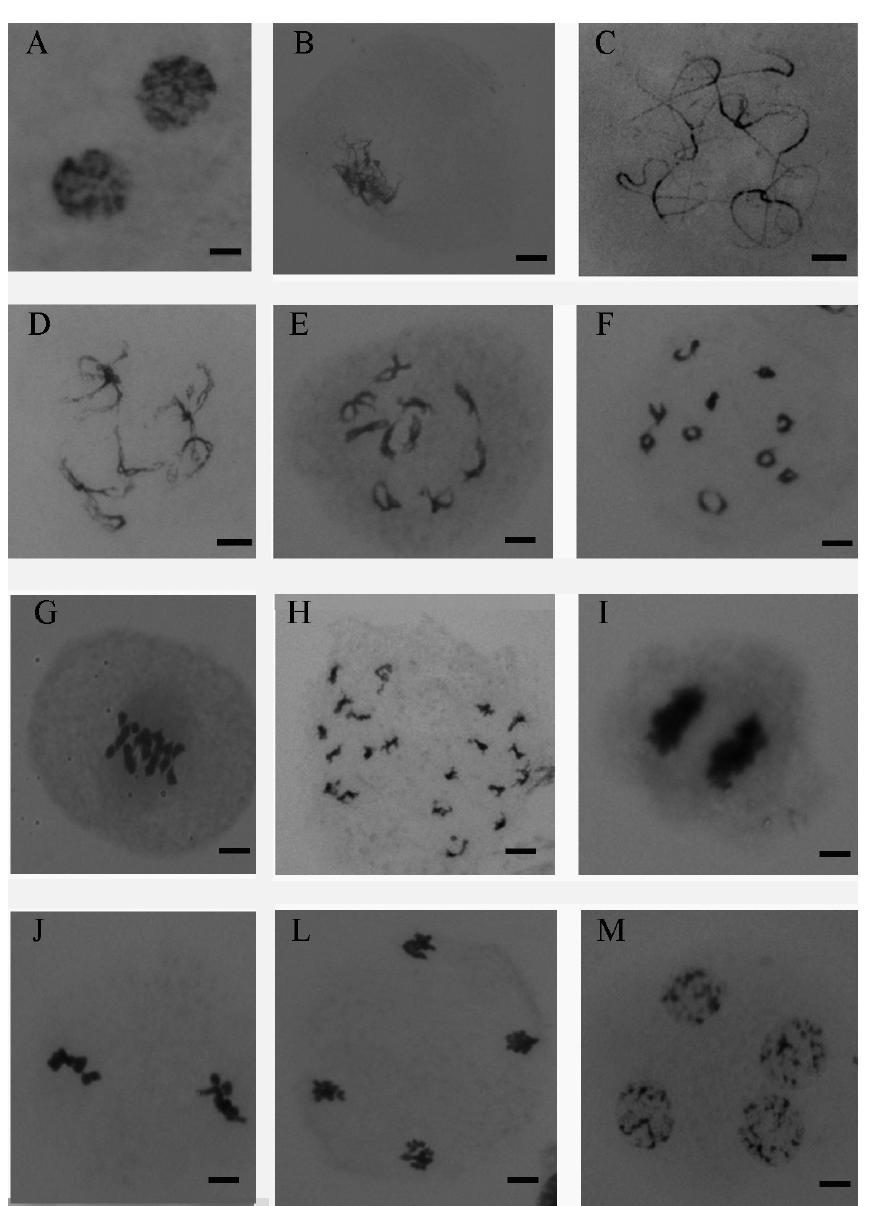
Fig. 1 – Meiosis of Heteropterys umbellata (A) Interphasic nucleus, (B) Zygotene, (C) Pachytene, (D) Initial diplotene, (E) Diplotene, (F) Diakinesis, (G) Metaphase I, (H) Anaphase I, (I) Telo- phase I, (J) Metaphase II, (L) Anaphase II, (M) Telophase II. Barr = 5 μ